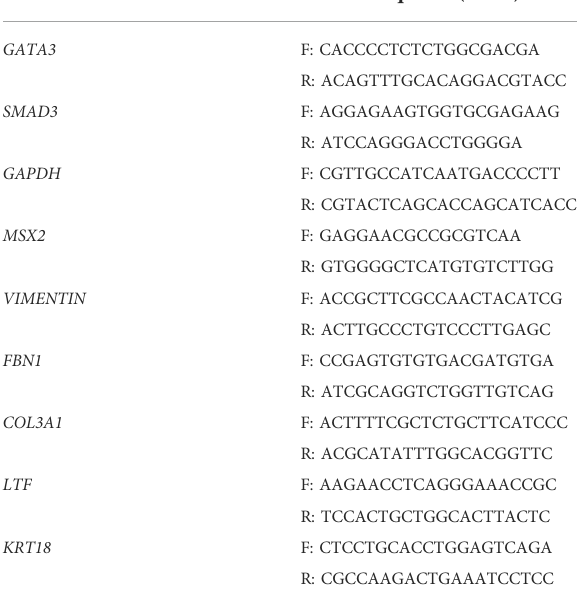
TABLE 2 Primers for